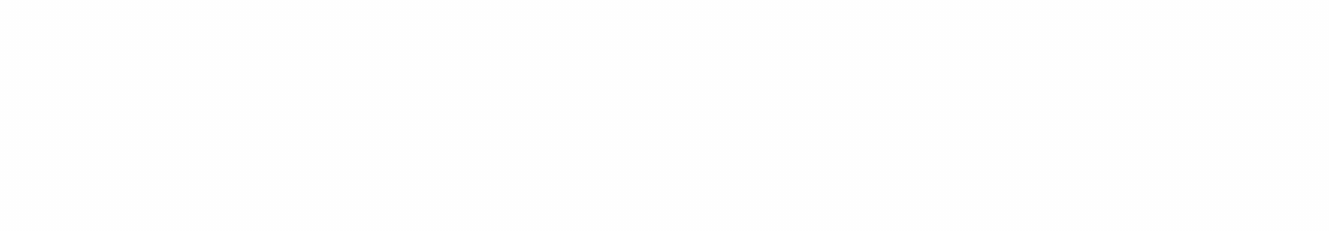
competition between the two firms, measured by the parameter fl, varies. Suitable values of the aggregate parameter AB, at which chaotic inter- vals for the restriction (13) exist, are obtained from the well known properties of the logistic map (see e.g. [12,23]). For example, at the param- eter value 2- 3.5748049387592... the